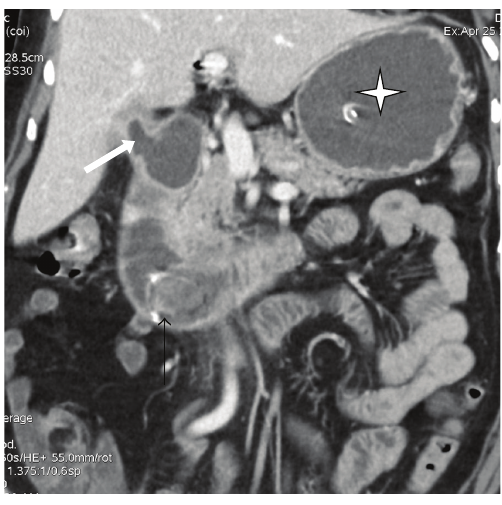
Figure 1: Contrast enhanced coronal reformatted MDCT image shows the cholecystoduodenal fistula (thick-white arrow) and calculus (thin-black arrow) in dilated third part of duodenum. Dilated fluid filled stomach is also seen (star).